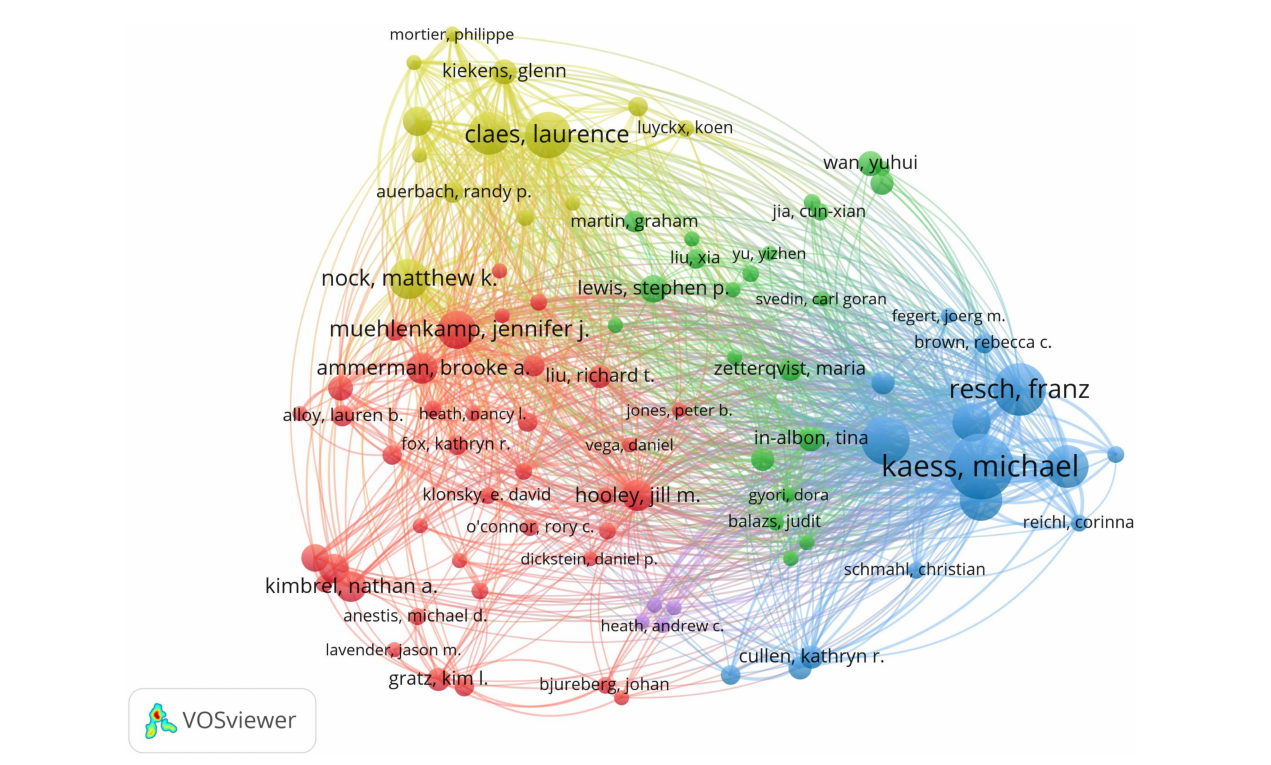
FIGURE8 Network visualization map of authors generated by VOSviewer. Each node represents an author and each color represents one cluster, the links between nodes represents cooperation of authors.